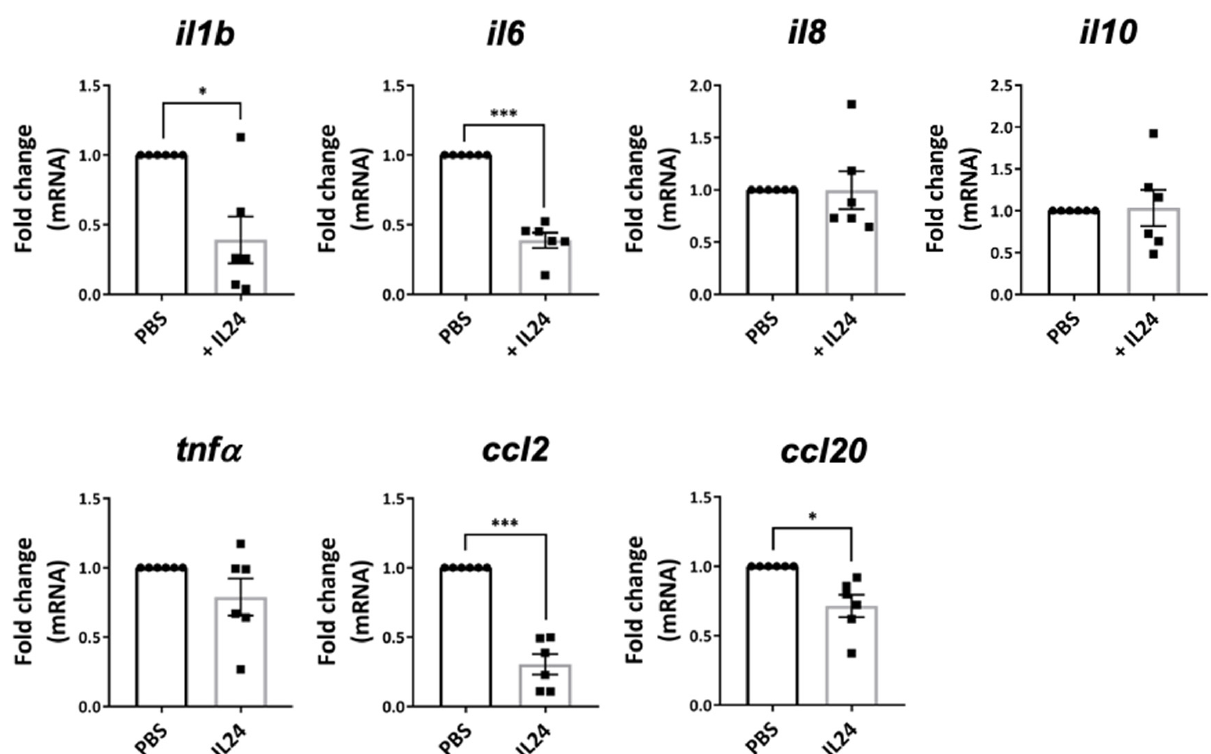
Figure 4. IL-24 suppressed the production of proinflammatory molecules in the retina. EAU was induced in C57BL/6 mice by active immunization with IRBP 1-20 and CFA. Each of the eyes was injected intravitreally with either recombinant IL-24 or PBS on the day of disease onset. The eyes were harvested 6–8 days after treatment. Retinas were isolated for cDNA synthesis. Relative gene expressions of il1b , il6 , il8 , il10 , tnfa , ccl2, and ccl20 were quantified by qPCR. Compiled data from two independent experiments (PBS: n = 6 eyes, IL-24-treated: n = 6 eyes). Means ± SEMs, * p < 0.05, *** p < 0.001, paired t test.